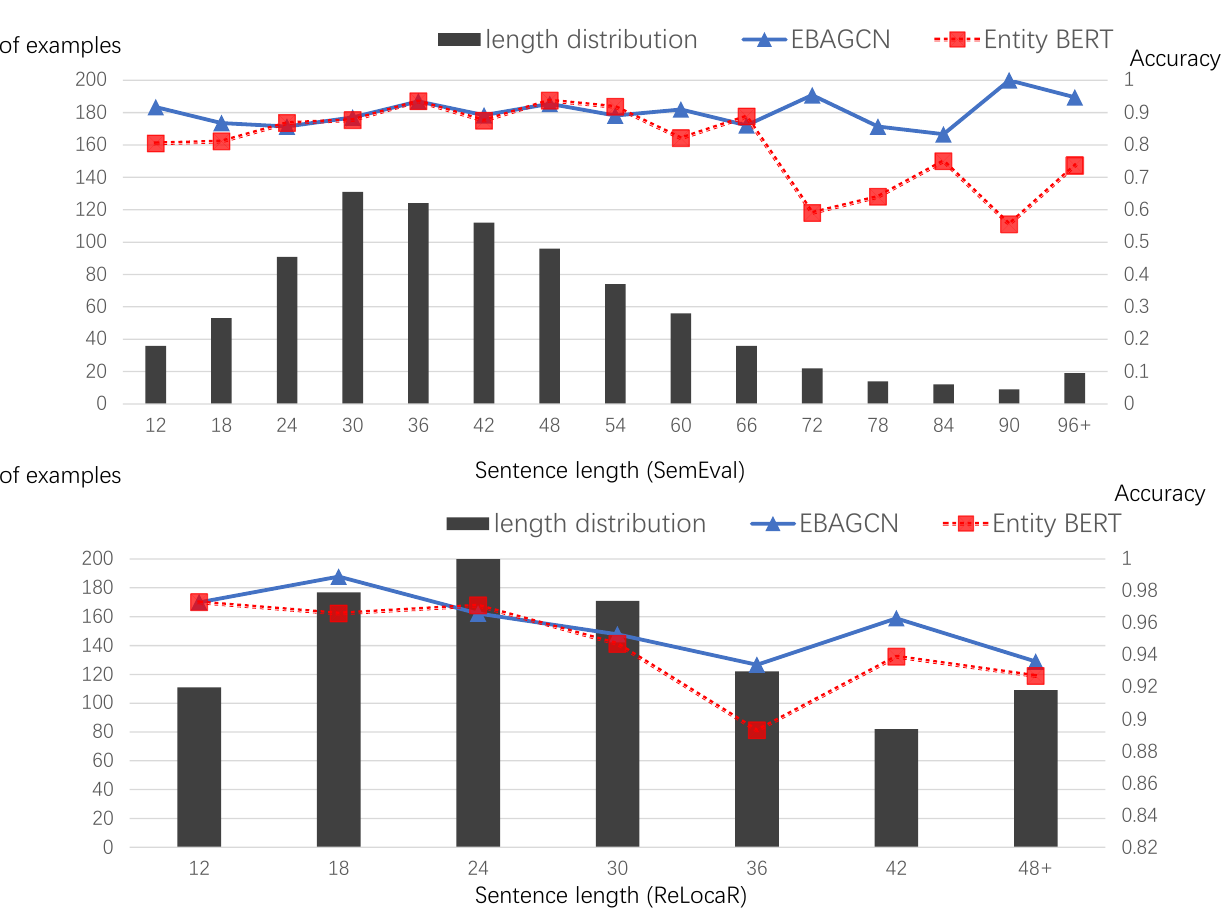
Figure 6. Experiment on ReLocaR and SemEval datasets w.r.t different sentence